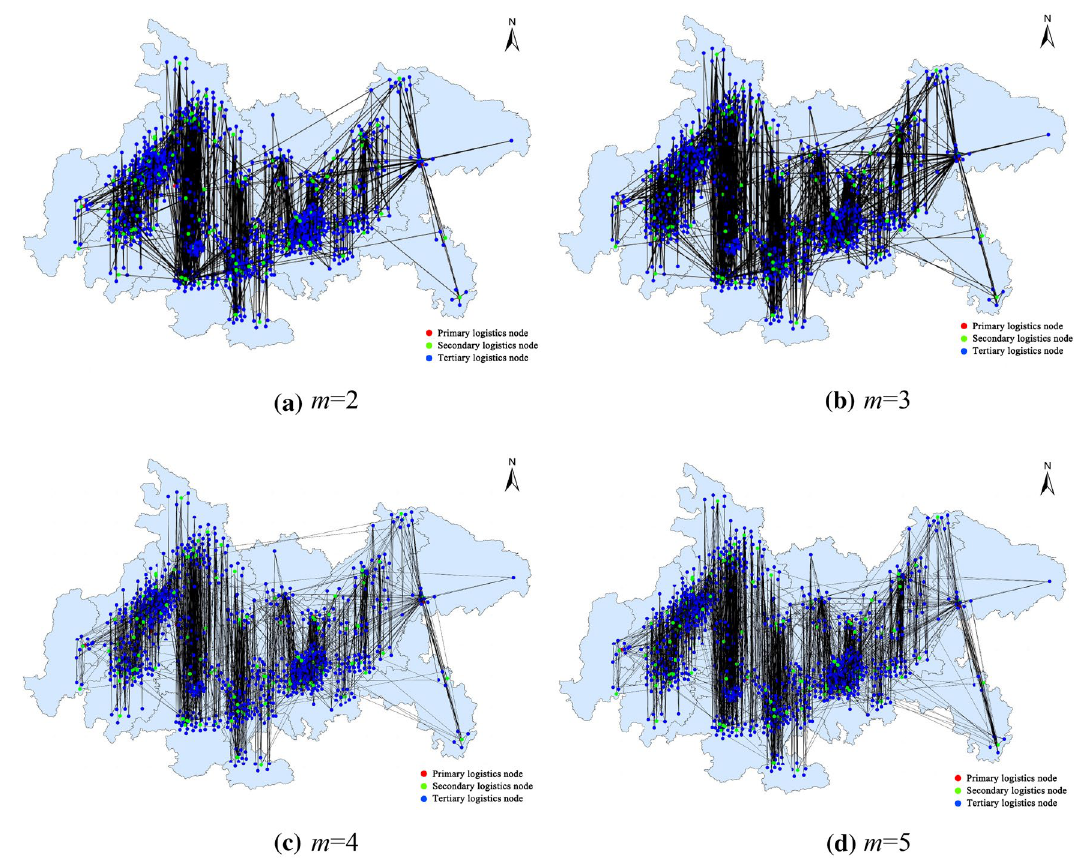
Fig. 5 The influence of parameter m on network evolution